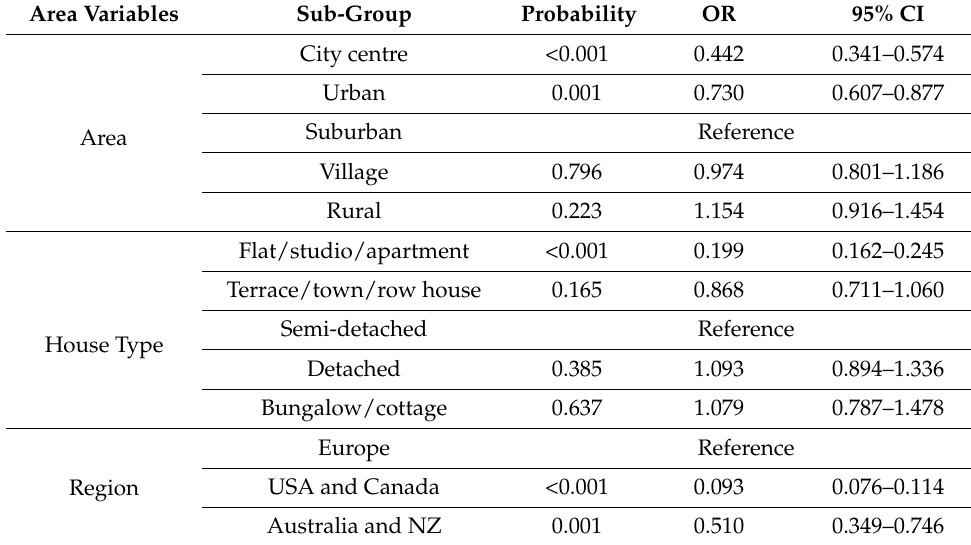
Table 5. Model 3, geographical features: Results of 4909 area variables tested through binary logistic regression for their association with cat lifestyle. Geographical variables where owners have increased odds of providing outdoor access are indicated by an OR greater than one, whilst an OR lower than one indicates geographical variables where owners have increased odds of keeping cats as